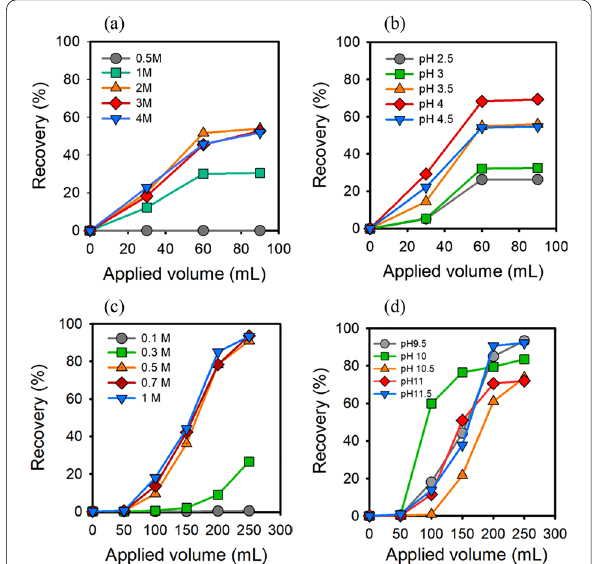
Fig. 1 Effect of sodium acetate ( a , b ) and ammonia ( c , d ) for elution of 5‑ALA from IEC. Recovery by using ( a) different concentration of sodium acetate at pH 3.5, and ( b) 2 M CH 3 COONa with different pHs. Recovery by using ( c) different concentration of ammonia at pH 11 and ( d) 1 M NH 4 OH with different